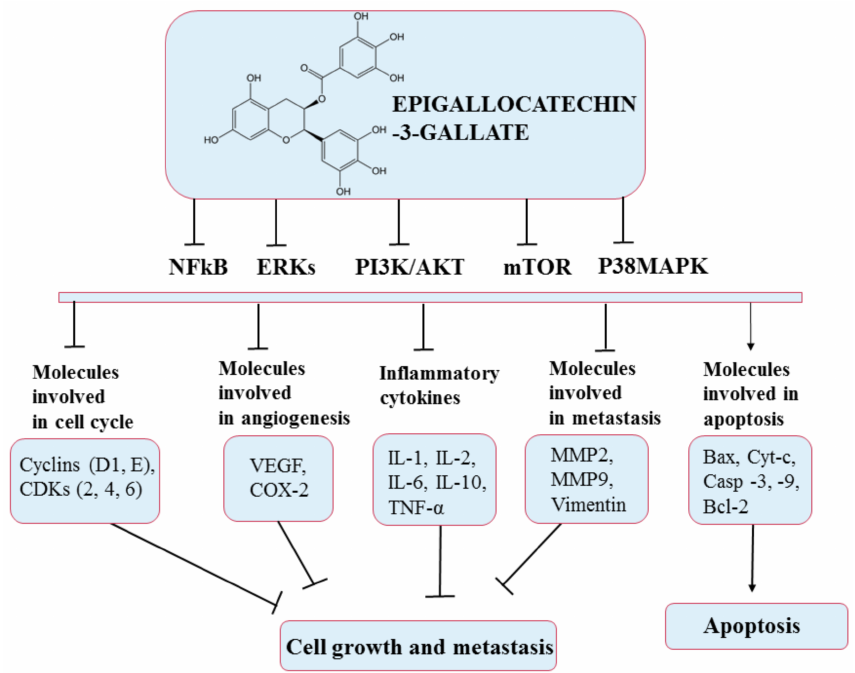
Figure 10. Chemical structure of epigallocatechin-3-gallate and its mechanism of action through different molecular targets that result in apoptosis or growth suppression and metastasis of